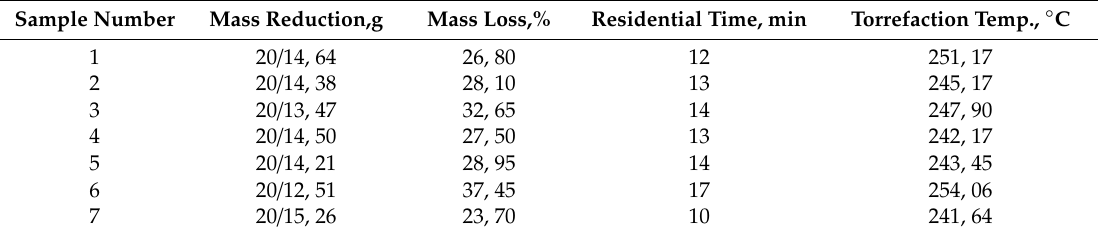
Table 2. Experimental research results of the Jerusalem artichoke torrefaction process in nitrogen using a batch